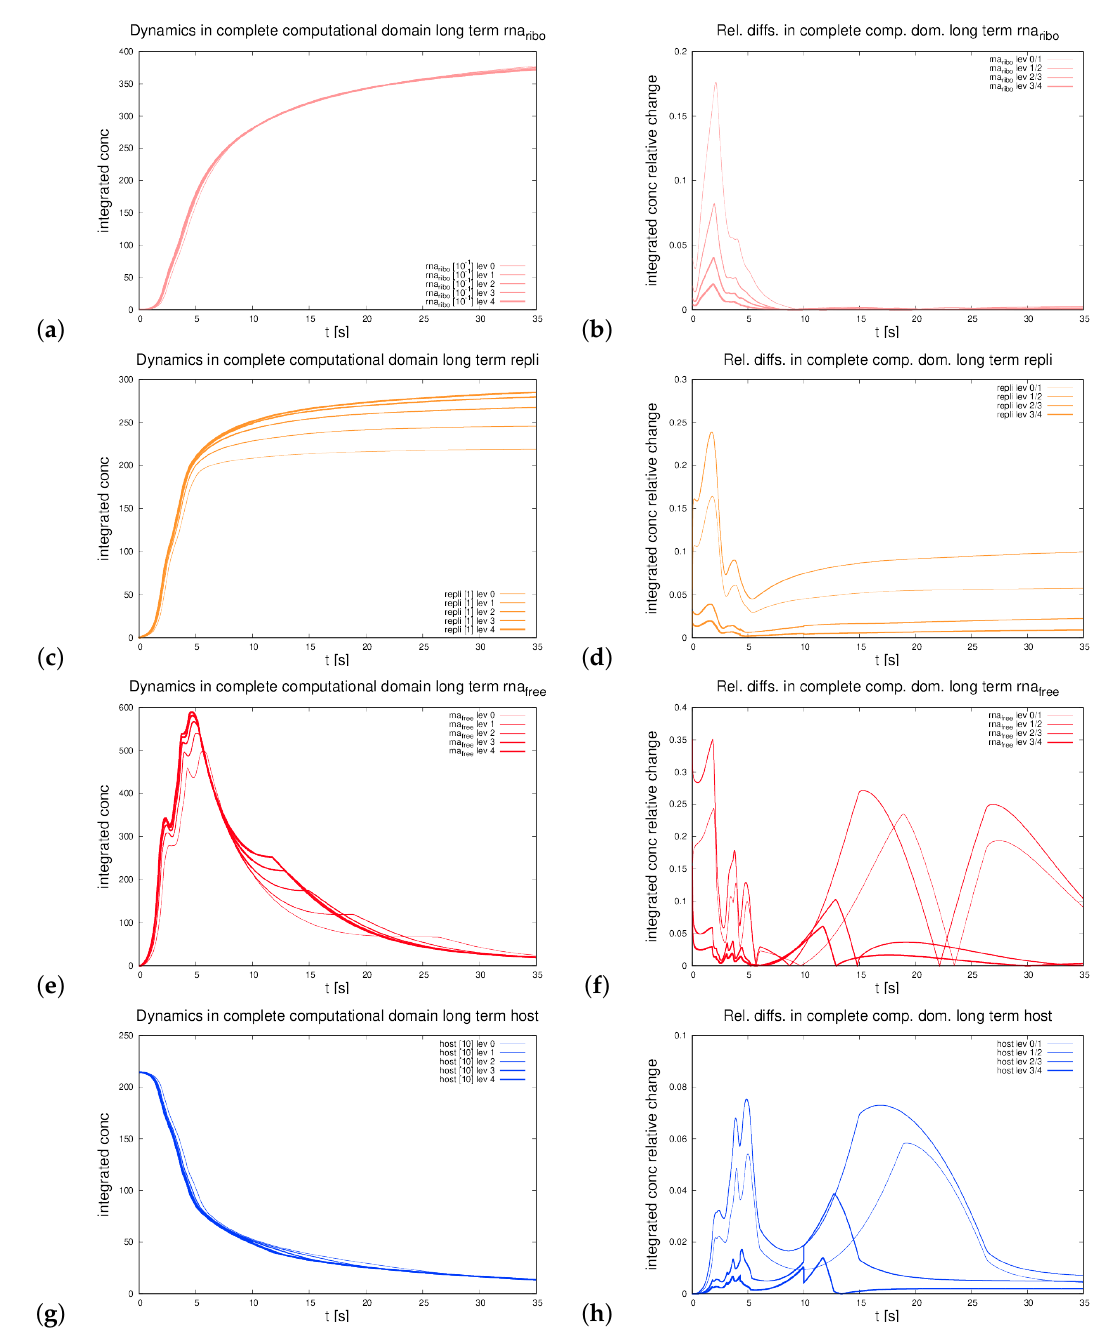
Figure A2. Development of integrated concentrations within complete computational domain under spatial refinement from level 0 (base level, direct reconstructed geometry) up to level 4 and relative differences, respectively, for concentrations of HCV RNA containing species and host factor. From top to down: Ribosomal bound HCV RNA, replication complex, free HCV RNA, and host factor. Left shows absolute values, while right shows relative differences. In detail: ( a ) Ribosomal bound RNA, absolute values for different grid levels, ( b ) ribosomal bound RNA relative differences for different grid levels, ( c ) replication complex, absolute values, ( d ) replication complex, relative differences, ( e ) free RNA, absolute values, ( f ) free RNA, relative differences, ( g ) host factor absolute values, ( h ) host factor relative